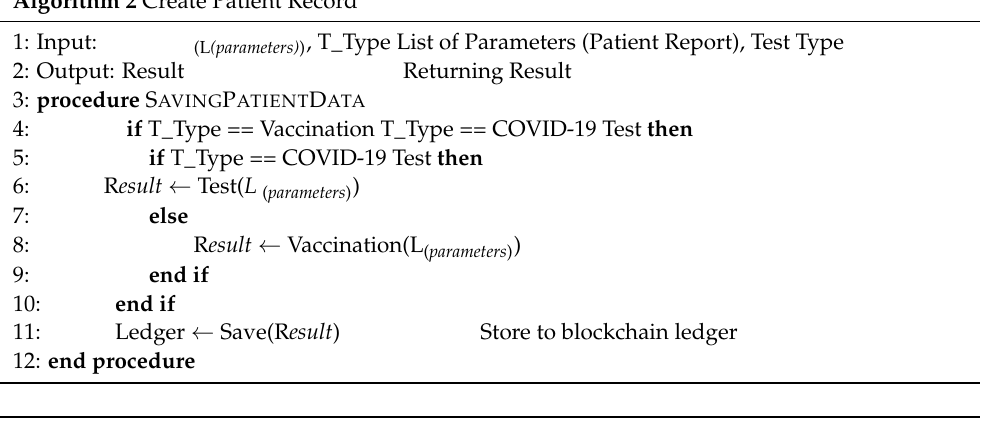
Algorithm 2 Create Patient Record